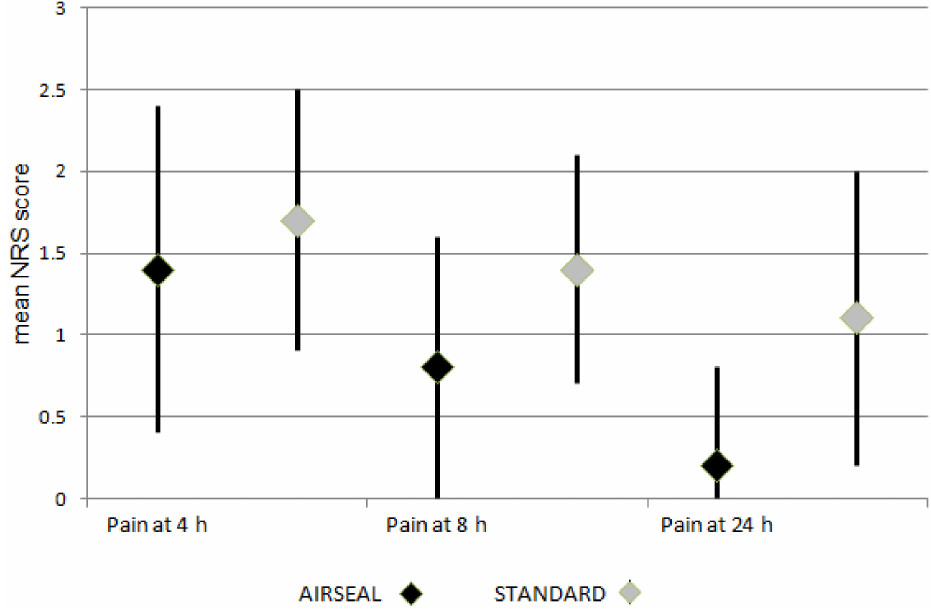
Figure 1. NRS pain control score of the two groups at 4, 8 and 24 h after